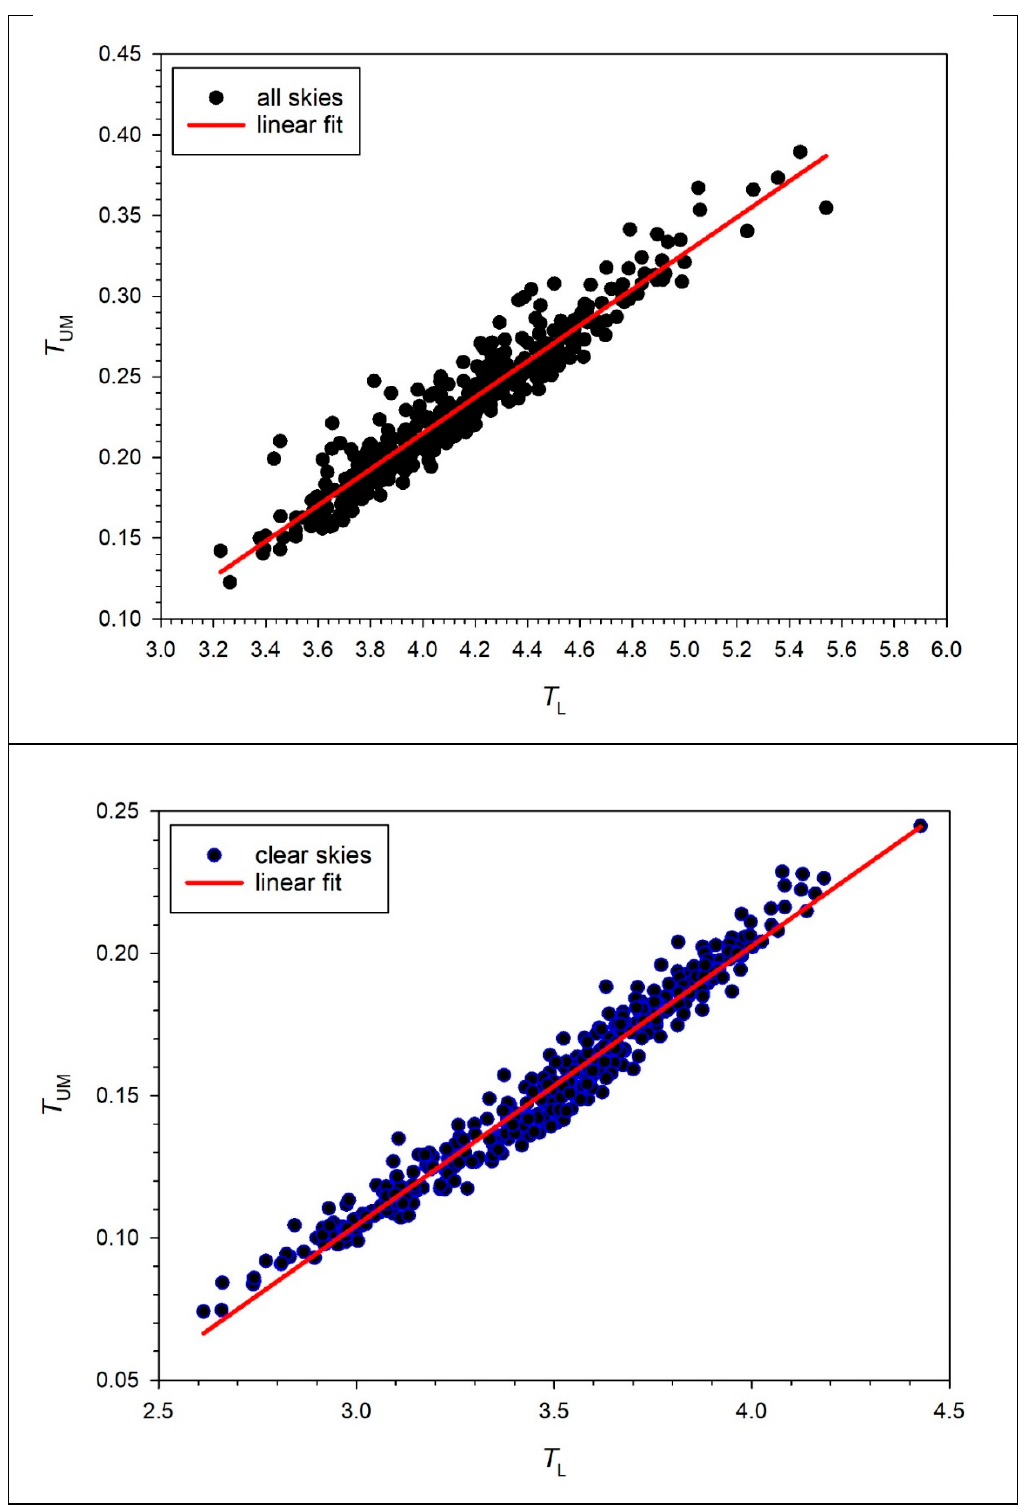
Figure 14. Monthly mean T UM vs. T L data pairs for all sites under all (upper graph) and clear-sky (lower graph) conditions in TATY and their best-fit lines. Linear regression equations: for all-skies T UM = − 0.2320 + 0.1120 T L , R 2 = 0.91; for clear skies T UM = − 0.1900 + 0.0980 T L , R 2 = 0.96.